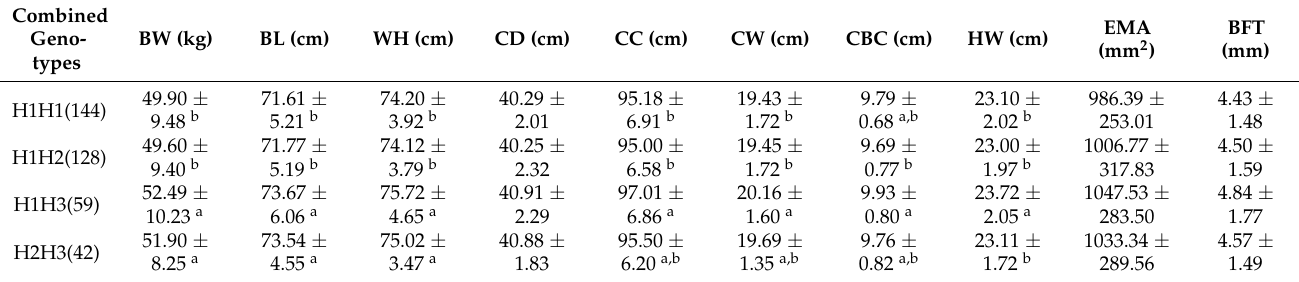
Table 5. Associations of combined genotypes with body measurements and ultrasound traits in GSTS flock.